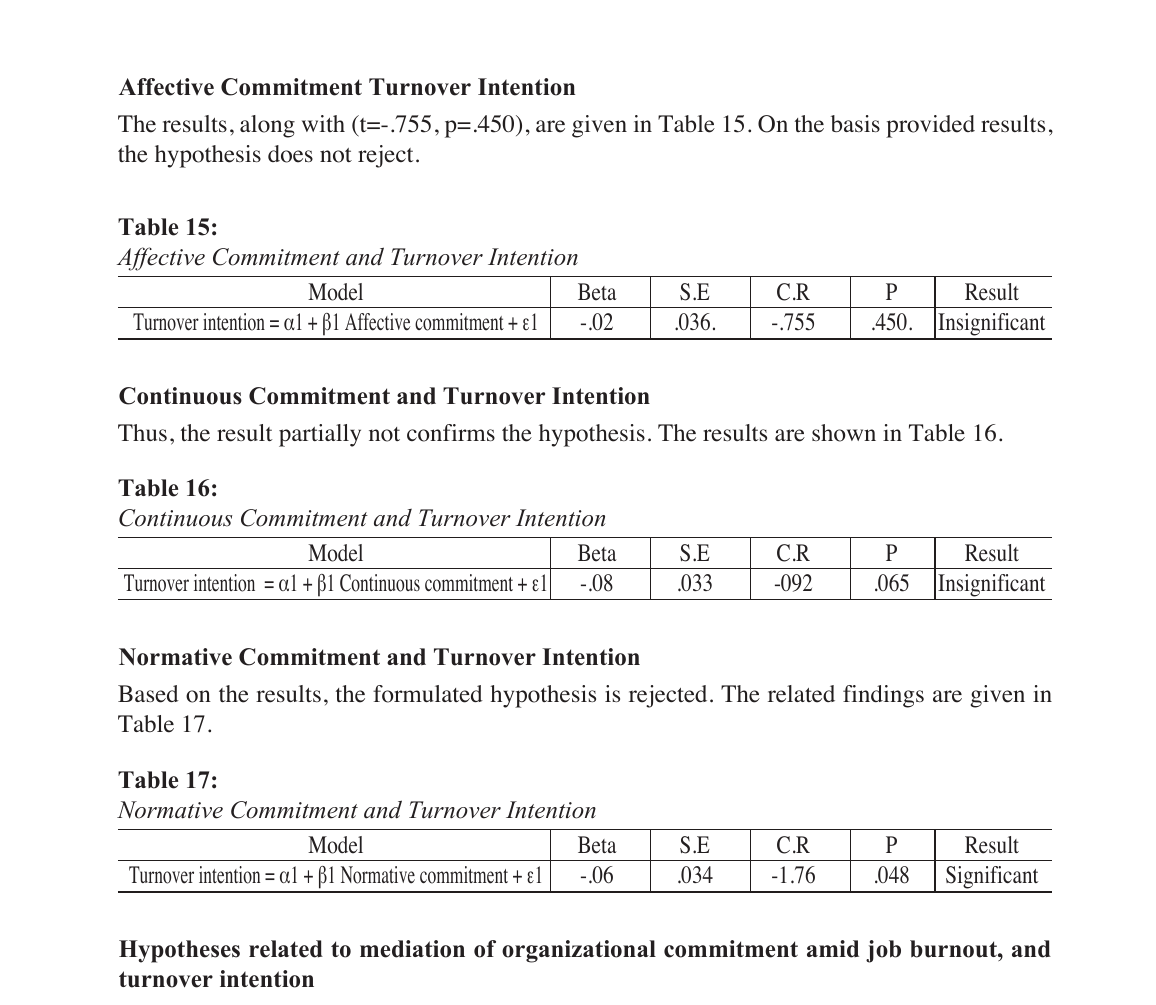
Normative Commitment and Turnover Intention